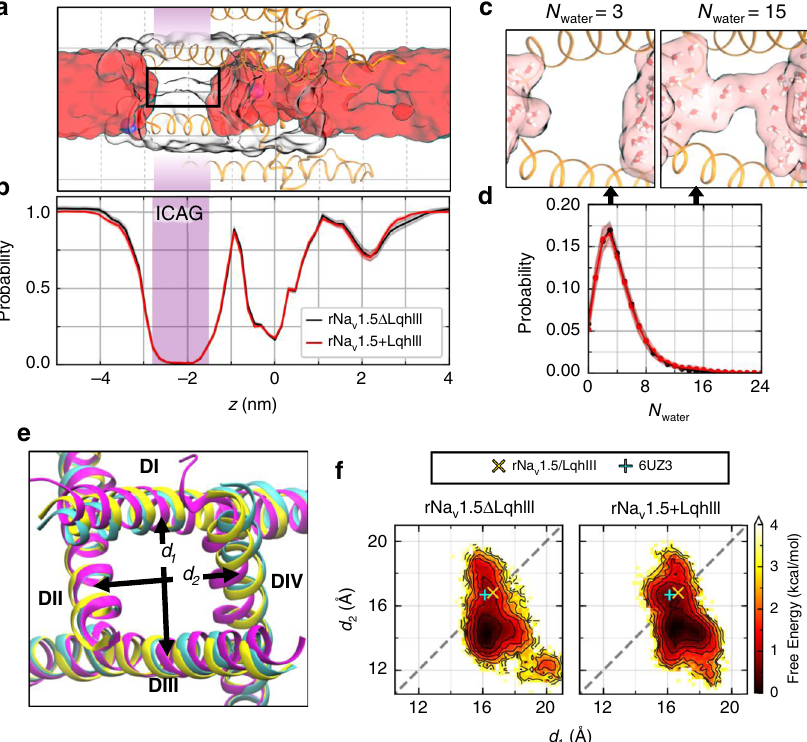
Fig. 6 Molecular dynamics analysis of hydration and Na + permeation through the rNa V 1.5 C /LqhIII complex. a Side view of rNa V 1.5 C (orange ribbons; domains II and IV) from MD simulations highlighting Na + ions (blue spheres), the water-occupied volume within a cylinder of radius 8.5 Å (red surface), and the protein-occupied volume within a cylinder of radius 12 Å (colorless surface). In this snapshot, the protein cavity (outlined in a black rectangle) at the intracellular activation gate (ICAG; purple shaded region, − 2.8 nm < z < − 1.5 nm) is dehydrated. The QuickSurf representation in VMD was used for surfaces. b Average hydration along the pore-axis for simulations of rNa V 1.5 C /LqhIII (red line) with and (black line) without the toxin. Overall pore hydration was unchanged whether or not the toxin is included in simulations. Shading corresponds to the standard error of the mean (s.e.m.). c Molecular representations of the gate containing N water = 3 (left) or 15 (right) water molecules. d Average probability distribution of N water in the gate. The gate is more likely to contain 10 or more water molecules when the toxin is present. Data points and shading represent mean and s.e.m. e Bottom (intracellular) view of the activation gate for cryo-EM rNa V 1.5 C (PDB ID: 6UZ3; cyan), cryo-EM rNa V 1.5 C /LqhIII (yellow), and an example conformation from the most sampled basin in MD (magenta) are superimposed. The distances d 1 , d 2 between opposing helices are shown schematically (see “ Methods ” ). f Free energy of d 1 vs. d 2 computed from MD simulations. The reference cryo-EM structures of (cyan + ) rNa V 1.5 C and (yellow×) rNa V 1.5 C /LqhIII are indicated. Contour lines are shown every 0.5 kcal/mol from 0 to 4 kcal/mol. In the simulations, the intracellular activation gate often contracts and adopts an asymmetric conformational basin with d 2 < d 1 , with the symmetric conformation observed by cryo-EM corresponding to a metastable state 0.5 to 1 kcal/mol higher in free energy. Time frames spread across 30 independent simulations of rNa V 1.5 C with or without LqhIII were used for analyses ( n = 29,026 frames for rNa V 1.5 C and n = 29,899 frames for rNa V 1.5 C lying from the right (extracellular) to the left (intracellular) with the surrounding S5 and S6 helices illustrated in orange (Fig. 6a). Water molecules (red) fi ll the inner part of the central cavity on the right and the intracellular exit from the pore on the left.